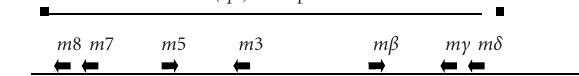
Figure 2. Organization of the E(spl)-C gene complex. Map of the E(spl)-C . The line represents genomic DNA, distal is to the left, and the black arrows indicate transcripts encoding the bHLH proteins (m, m5, m7, m8, m β , m γ , and m δ ). This dia- gram is modified from de Celis et al